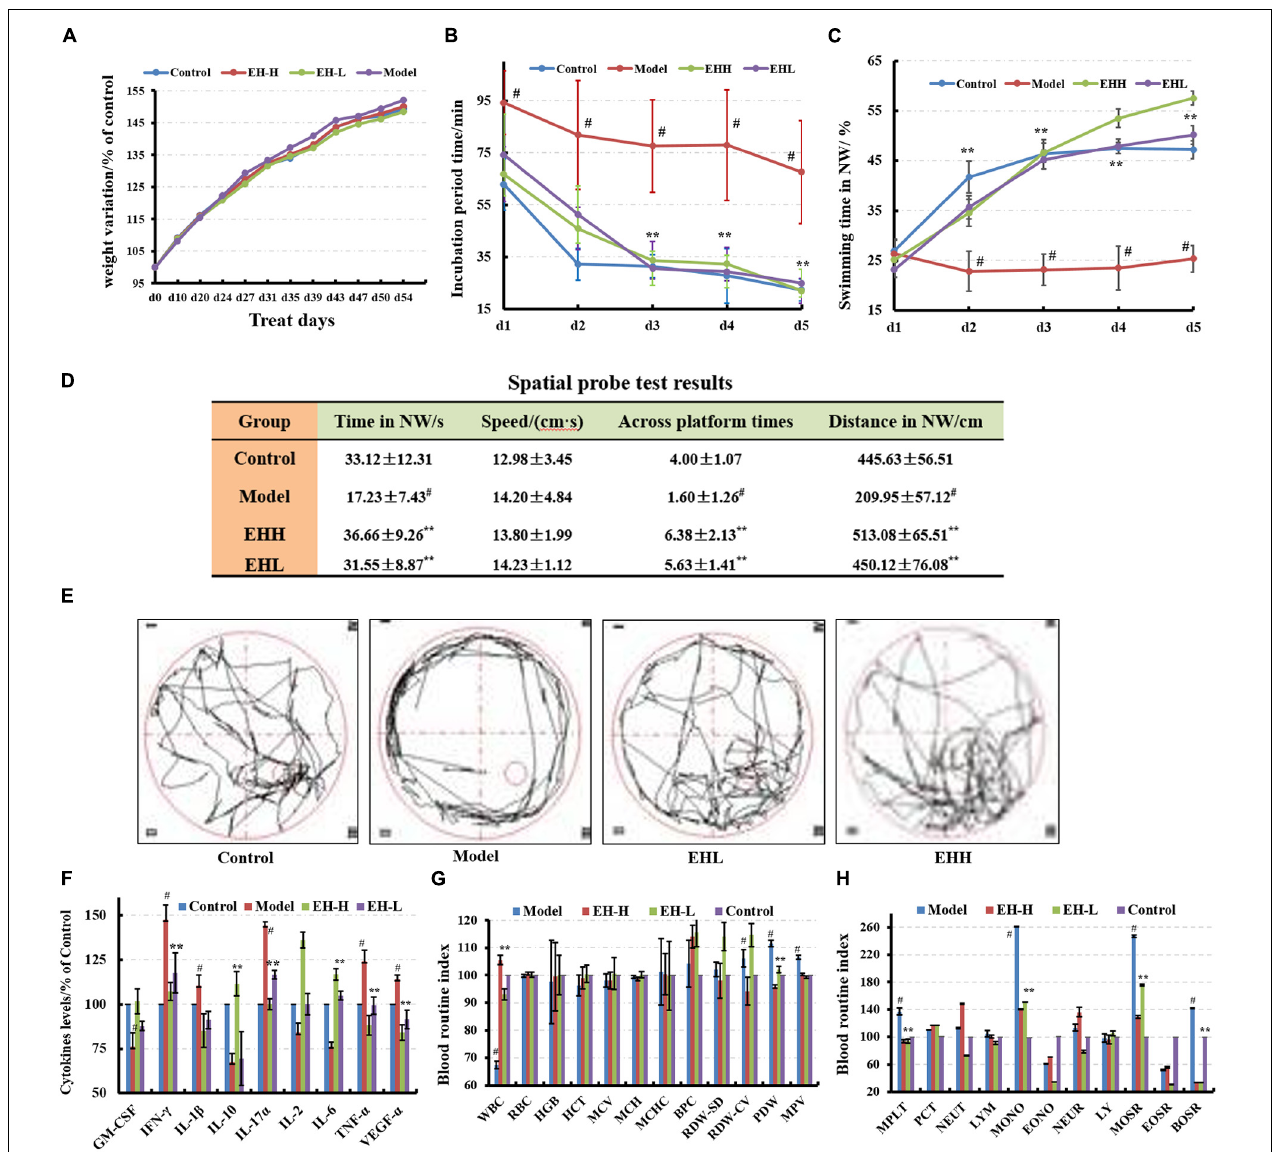
FIGURE 1 | Effects of ethanol:water (8:2) extracts from Hericium erinaceus (EH) on D -galactose-induced deficit in rats. (A) Body weight changes during the treatment; (B,C) water maze tests results at the specified incubation periods and swimming times in NW; (D) spatial probe test results; (E) swimming trajectory during the spatial probe test; (F) cytokine levels of GM-CSF, TNF- γ , 1L-10, IL-2, 1L-17 α , 1L-6, TNF- α , and VGEF- α in serum; (G,H) routine blood index changes. Control group (oral distilled water), model group [intraperitoneal injection (i.p) of 100 mg/kg/d D -galactose], low-dose group (concomitant administration by i.p injection of 100 mg/kg/d D -galactose and gavage at a dose of 50 mg/[kg · d] ethanol:water (8:2) extracts from H. erinaceus (EH)), high-dose group (concomitant administration by i.p injection of 100 mg/kg/d D -galactose and gavage at a dose of 50 mg/[kg · d] ethanol:water (8:2) extracts from H. erinaceus (EH)). Values are expressed as mean ± SD, # p < 0.05 vs. control group, ∗ p < 0.05, ∗∗ p < 0.01 vs. model group, indicates significant differences compared with the model